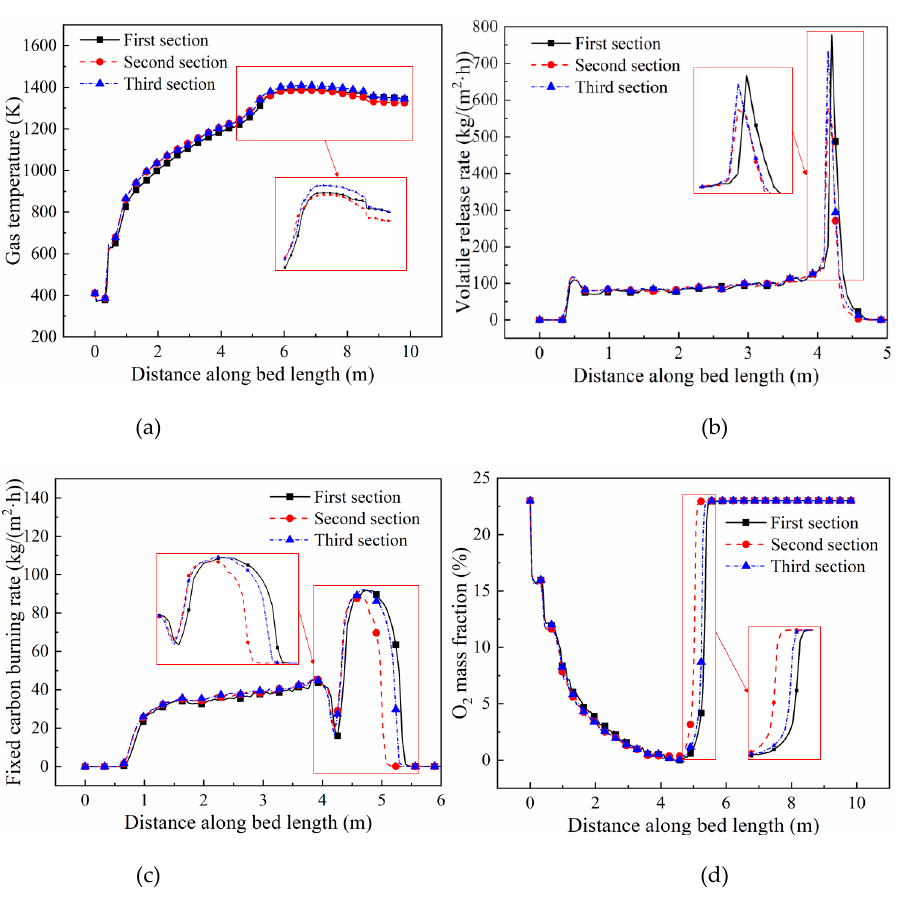
Figure 8. Combustion parameters along the bed length: ( a ) Variation of gas temperature along the length of the bed; ( b ) Variation of volatile release rate along the length of the bed; ( c ) Variation of fixed carbon burning rate along the length of the bed; ( d ) Variation of O 2 mass fraction along the length of the bed.